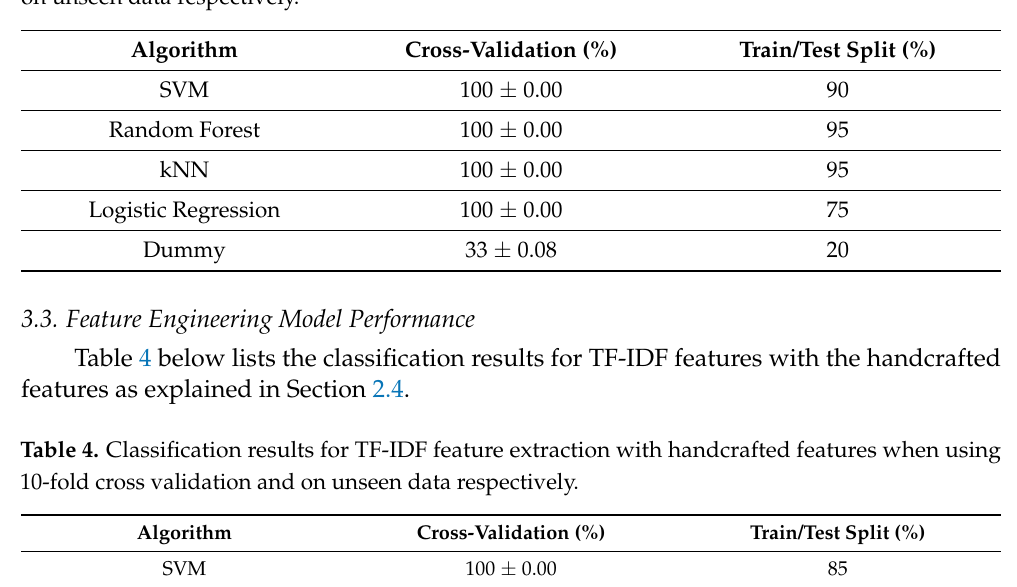
Table 3. Classification results for TF-IDF feature extraction when using 10-fold cross validation and on unseen data respectively.